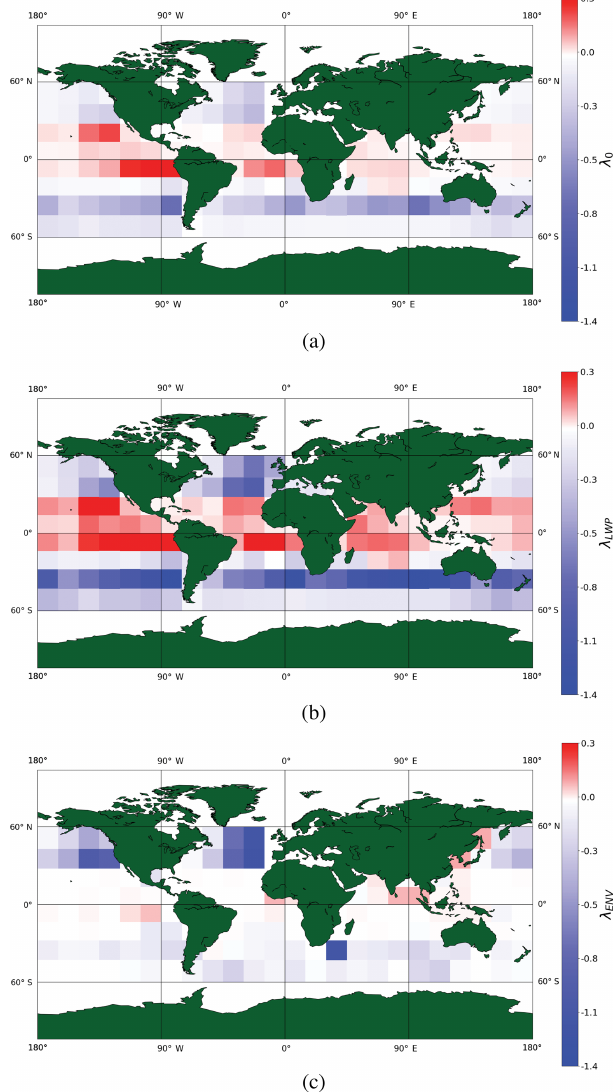
Figure 8. The sensitivity of CRE to aerosol evaluated regionally with (a) no regime constraints, (b) only cloud state constraints, and (c) only environmental constraints for each 15 ◦ by 15 ◦ region. Total sensitivities are (a) − 11 . 8, (b) − 28 . 5, and (c) − 13 . 8 when weighted by occurrence Wm − 2 ln(AI) − 1 .